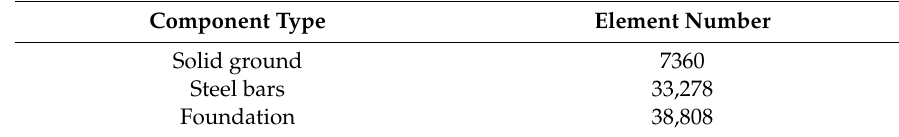
Figure 6. Three-dimensional numerical model. Table 1. Element number of different components.